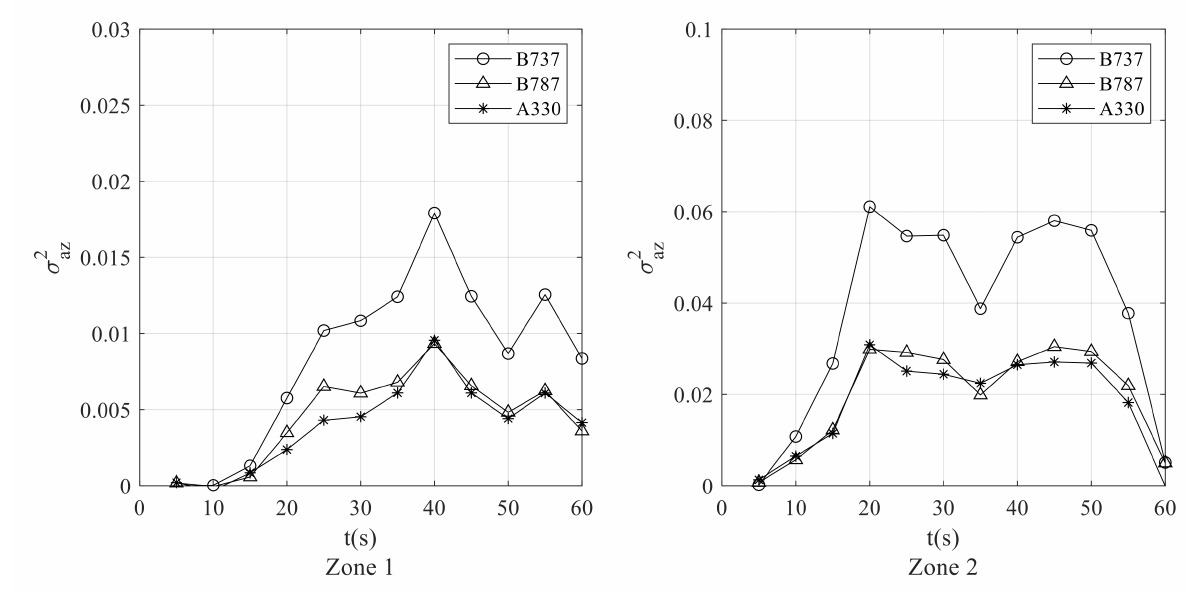
Figure 14. The bumpiness severity of different aircraft